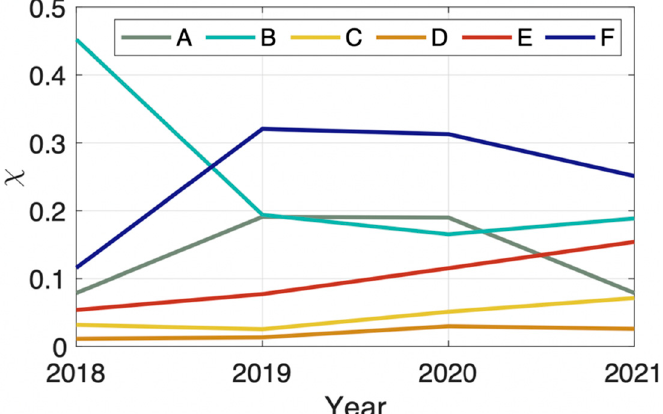
Figure 1. Development trend under different primary indexes. A, B, C, D, E, and F represent the number of institutions, full-time employees, collection, opening and utilization of archives, the floor space of archives, and digital archives certified by the competent archives department at or above the provincial level, respectively.